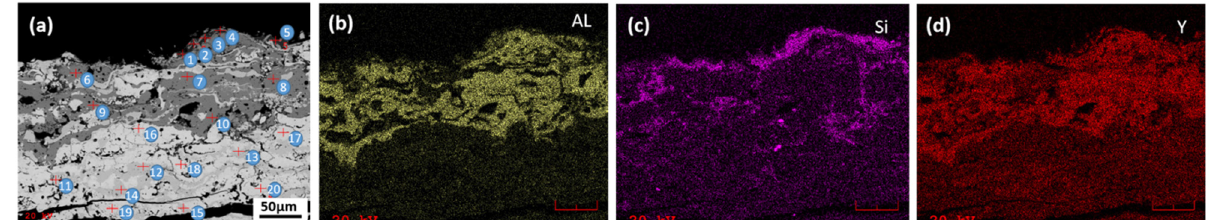
Figure 14. SEM cross-sectional images and the corresponding scanning maps of EDXS elements for the tri-phase TBC sample after CMAS corrosion tests at 1250 °C for 120 h: ( a ) Backscattered electron (BSE) image; ( b ) element scan map for aluminum; ( c ) element scan map for silicon; ( d ) element scan map for yttrium. Table 2. Results of SEM/EDXS analyses in the tri-phase (t’+c+YAG) TBC after the CMAS corrosion test at 1250 °C for 120 h.